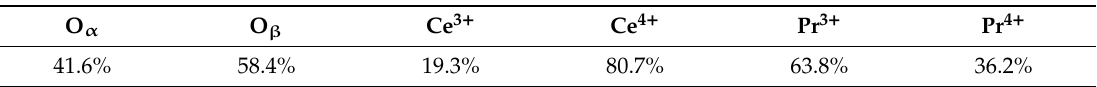
Table 1. Relative abundancies of di ff erent species on the surface of the Ce50Pr50 catalyst derived from the deconvolution of the XP spectra.